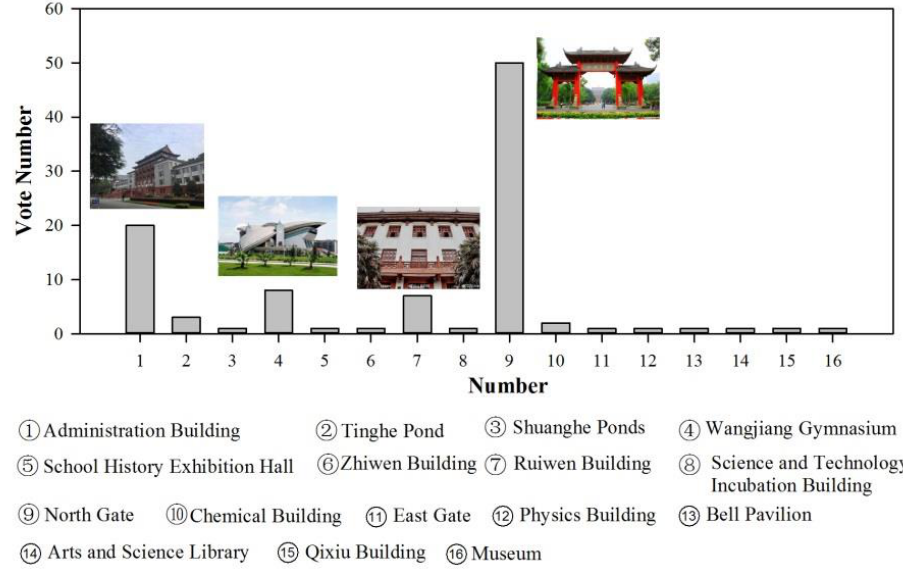
Figure 7. Vote statistics for different buildings.